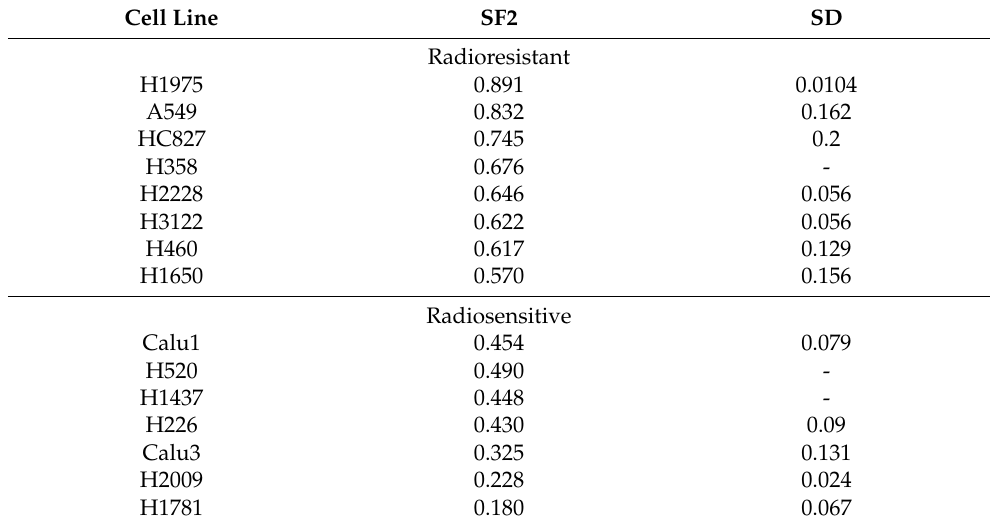
Table 1. Values of the surviving fraction at 2 Gy (SF2) of all cell lines. Results of clonogenicity